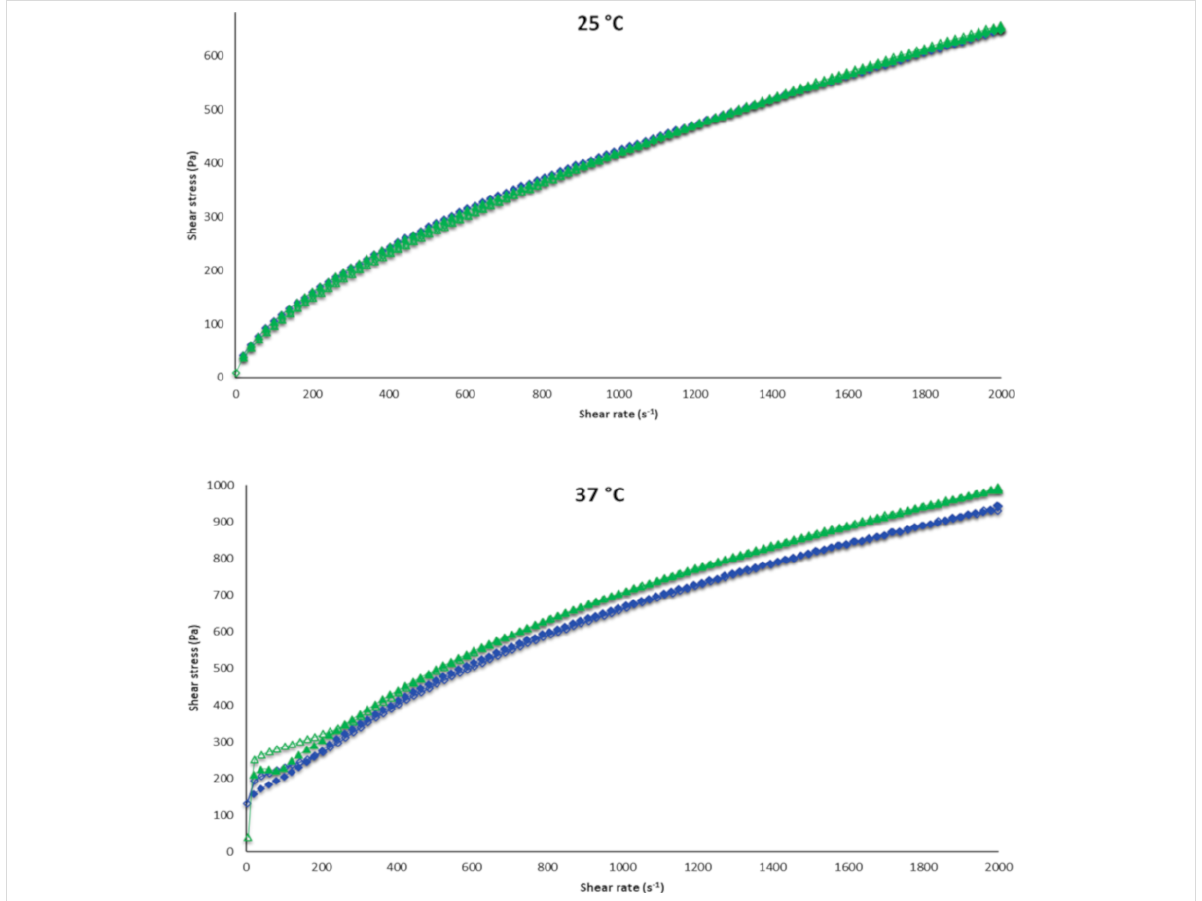
Figure 6: Flow rheograms of formulations containing 15% (w/w) P407, 0.25% (w/w) C974P ( ∆ - green) and 15% (w/w) P407, 0.25% (w/w) C974P and 0.08% (w/w) CUR ( ◊ - blue). The closed symbols represent up-curve and open symbols represent down-curve. Error bars have been omitted for clarity, and each rheogram represents the average of at least three replicates with variation coefficient 10%.